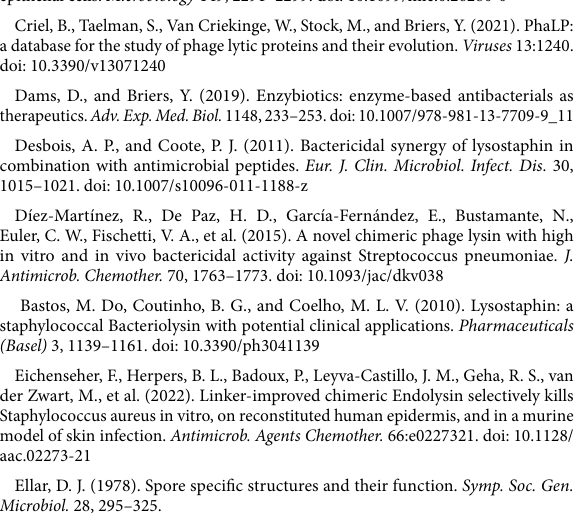
Figueroa-Cuilan, W. M., Randich, A. M., Dunn, C. M., Santiago-Collazo, G., Yowell, A., and Brown, P. J. B. (2021). Diversification of LytM protein functions